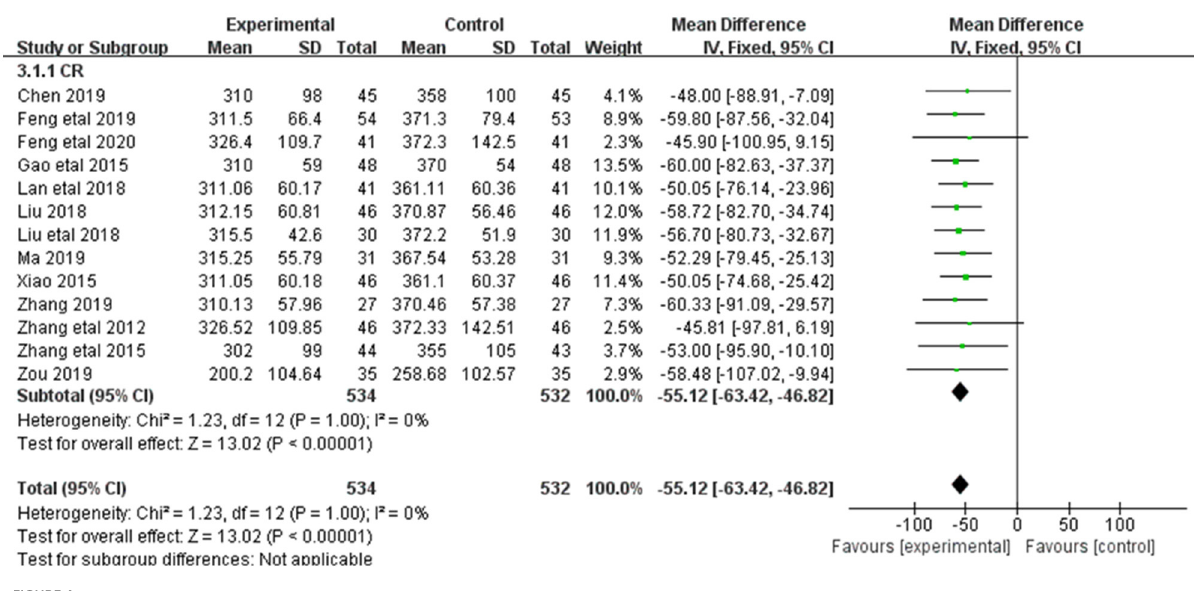
FIGURE4 Forest plot of analysis of the Scr of treating CHF.